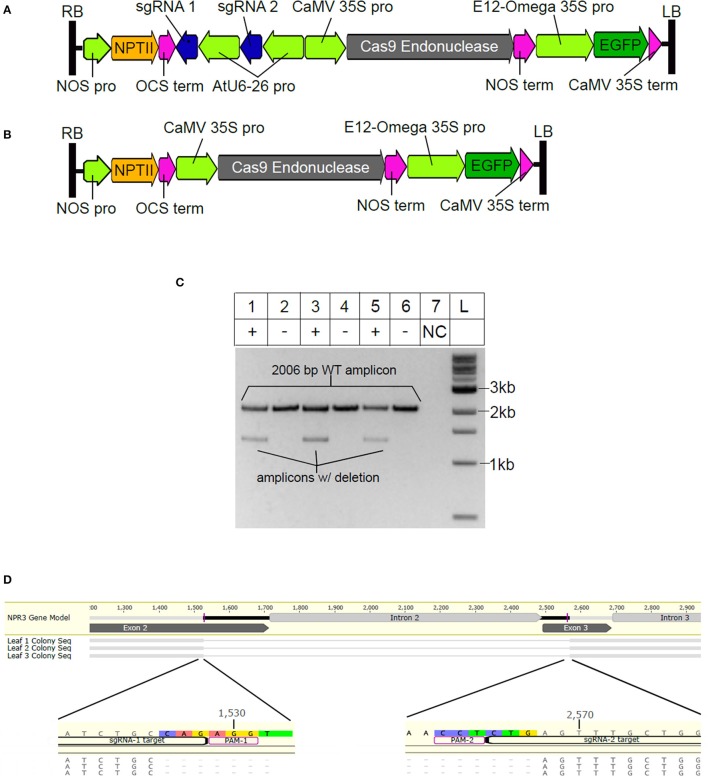
Vector design and demonstration of sgRNA activity in vivo. (A) T-DNA region of vector pGSh16.1010. RB and LB indicate right and left borders, (B) T-DNA region of vector pGSh16.1012, a vector control lacking sgRNAs. (C) Agarose gel electrophoresis of TcNPR3 target region. For this analysis, three different leaves were cut into two sections and the two sections of each leaf were transformed with either pGSh16.1010 (+) or pGSh16.1012 (-). DNA from each pair of samples was extracted and used as a PCR template in separate reactions (lanes 1 and 2, lanes 3 and 4, lanes 5 and 6). Lane 7 (labeled NC) contains a control PCR reaction (no DNA template). Lane L contains 500 ng of 1 kb ladder (NEB). (D) Alignment of sequences cloned from lower bands extracted from gel in (C). NPR3 Gene Model is the reference sequence from the Criollo genome database. Labels Leaf 1, 2, and 3 correspond to DNA samples used as template for reactions in lanes 1, 3, and 5 of (C).